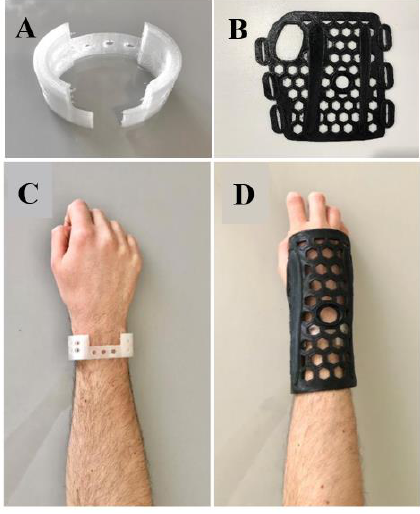
Figure 2. Modeling of the meshes printed on the wrist of a person to illustrate the way of use, where ( A ) it is the inner fixation mesh printed; ( B ) the outer immobilization mesh printed; ( C ) only the placement of the inner fixation mesh and ( D ) the joint use of the fixation mesh with the immobili- zation mesh.